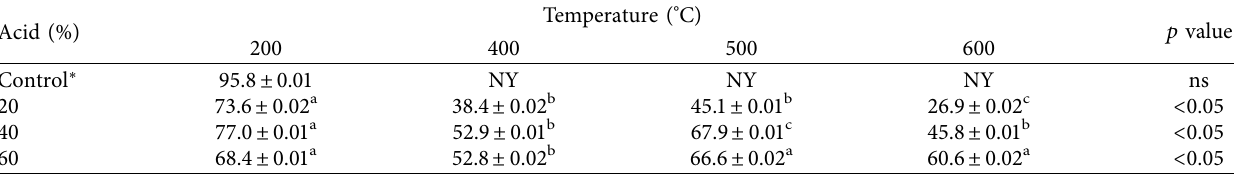
Table 2: Yield of activated carbon from H